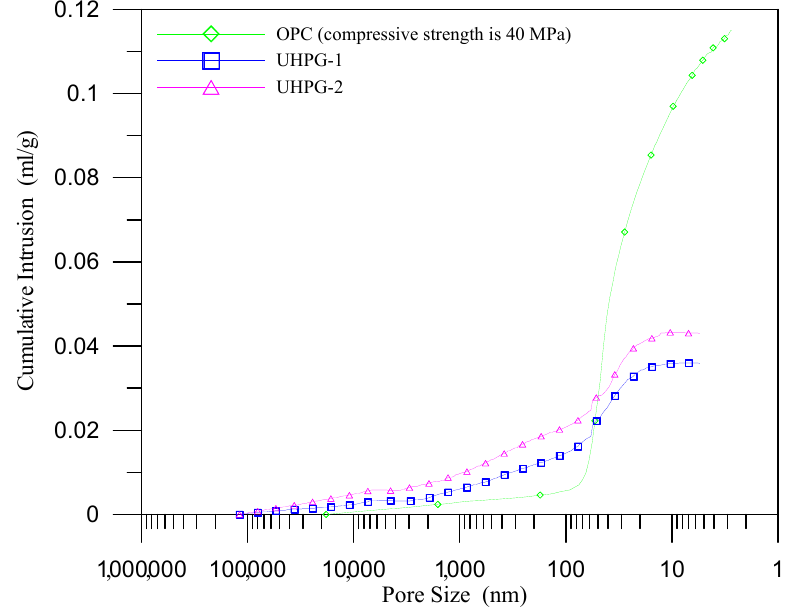
Figure 11. Pore size distributions of UHPG and OPC.